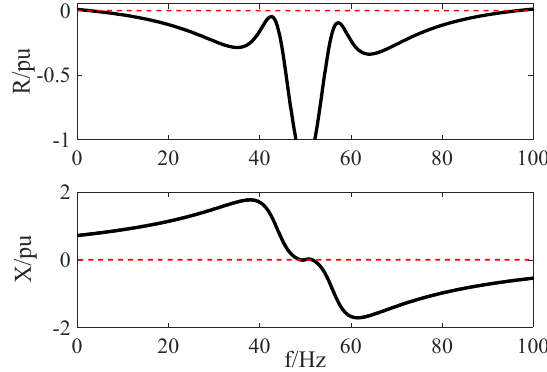
Figure 7. Port-impedance characteristics of Type-IV wind generator.